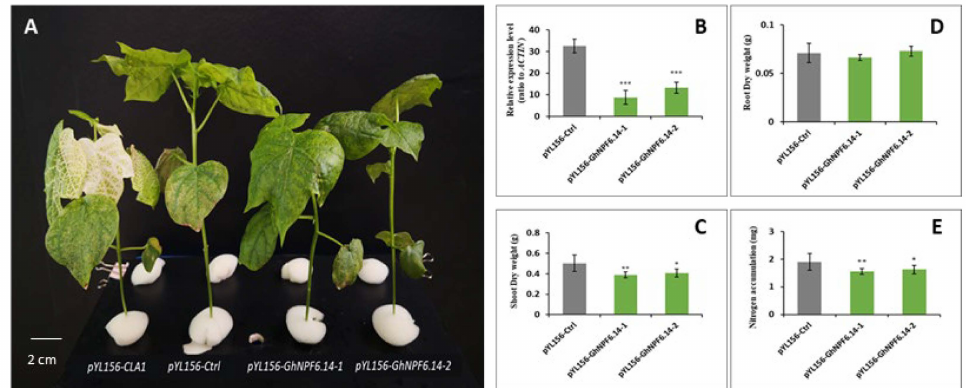
Figure 7. Silencing of GhNPF6.14 gene by VIGS and plant growth and nitrogen accumulation analysis. ( A ) The phenotype of control and gene-silenced plants with albino appearances. CAL: chlorophyll deficient, pYL156-Ctrl : negative control. ( B ) Re-elevate expression level. ( C ) Shoot dry weight. ( D ) Root dry weight. ( E ) Nitrogen accumulation. Error bars indicate the standard deviations of three independent experiments (*/**/*** indicate a significant difference with Ctrl, where * indicates p < 0.05, ** indicates p < 0.01 and *** indicates p <